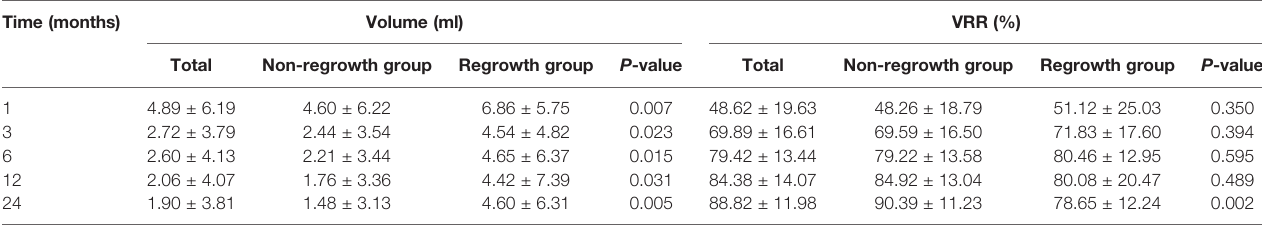
( Table 4 ). A nomogram based on these three independent factors to predict nodule regrowth after RFA was constructed ( Figure 4 ). Each factor was allocated a predicting score, and the sum of three scores was located on the total points axis, suggesting the prediction of regrowth probabilities. Higher total points were associated with a higher regrowth probability during the follow- up. The discriminative ability of the model for regrowth was assessed using the C-index, which was 0.779 (95%CI 0.686 – 0.872) ( Figure 5 ). The accuracy of the model and potential model over fi t were assessed by bootstrap validation with 1,000 re-samplings.